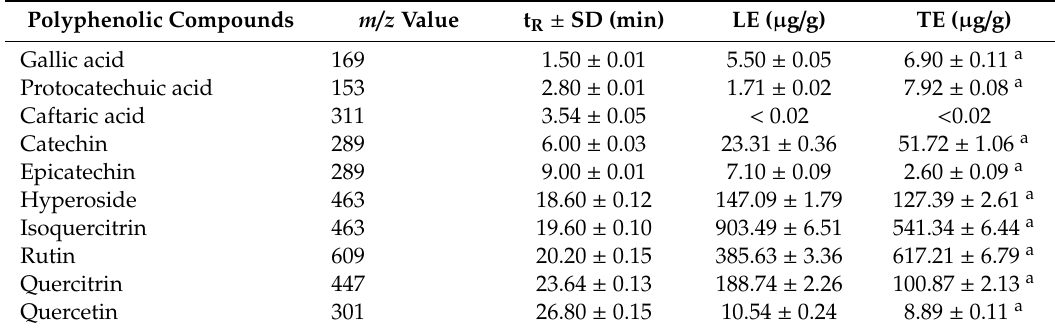
Table 2. Polyphenols identified in V. vinifera LE and TE by liquid chromatography coupled with mass spectrometry in tandem (LC-MS / MS) ( µ g / g plant material).